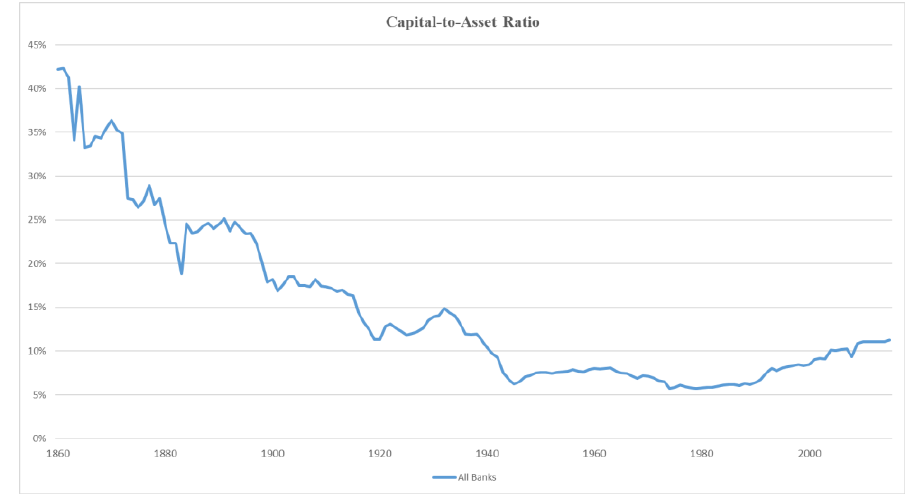
Figure 3. Capital-to-Asset Ratio. Source: Historical Statistics of the United States: Colonial Times to 1957. U.S. Department of Economics, Bureau of the Census, 1961.